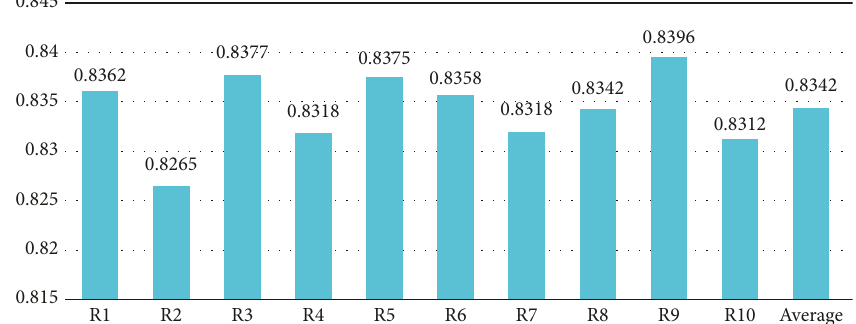
Figure 11: Results of 10 runs of the proposed method in the evaluation criterion of area under curve with the average of 10